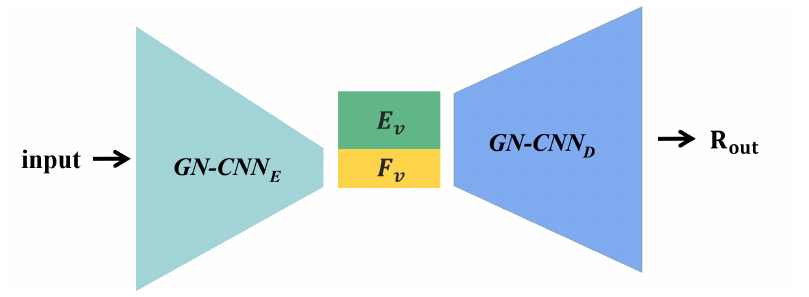
Figure 3. Warm start strategy for